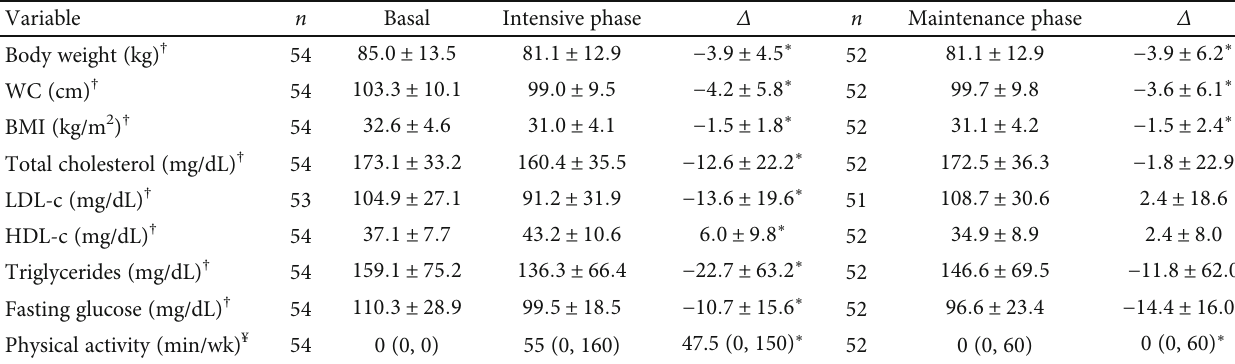
WC: waist circumference. Δ : change value. † Expressed as the mean ± SD . ¥ Expressed as the median and interquartile ranges. ∗ p ≤ 0 : 05 . Paired t -test (normally distributed variables) and Wilcoxon rank-sum test (variables with nonnormal distribution). Table 4: Comparison of obesity parameters, metabolic markers, and physical activity of the participants (PA). Variable n